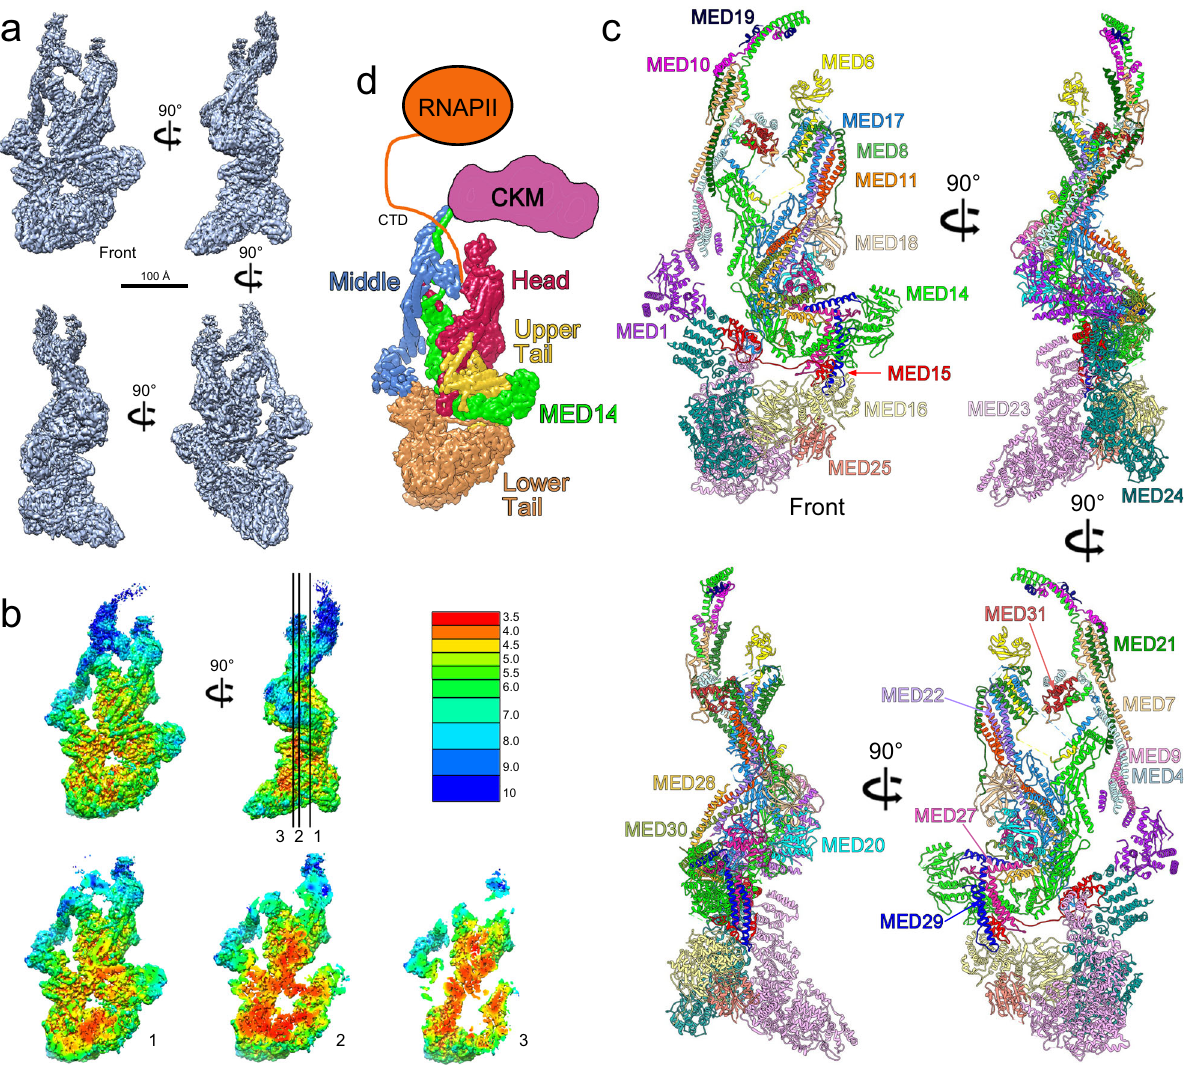
Fig. 1 4.0 Å resolution cryo-EM map and molecular model of mammalian Mediator. a mMED cryo-EM map at 4.0 Å resolution. b Local resolution in the mMED map points to high mobility of the Middle module and domains that form the CTD-binding gap. Slicing through the map highlights comparatively high (~3.5 Å) resolution throughout the core of the complex. c Mammalian Mediator molecular model. d Schematic representation of mMED ’ s modular organization and its interaction with RNA polymerase II (RNAPII, through the polymerase CTD) and the Cdk8 kinase module